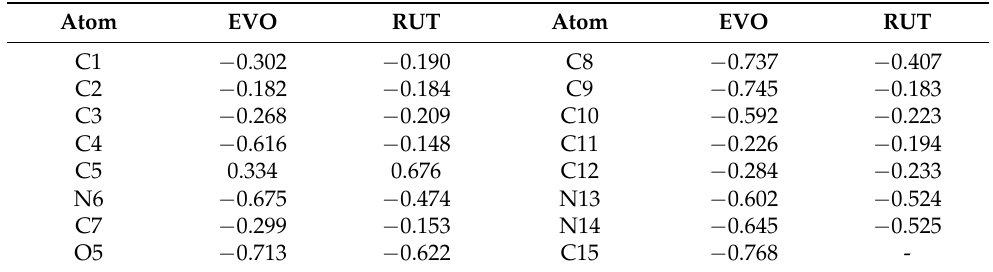
Table 1. Natural population analysis (NPA) charge on the atoms of evodiamine (EVO) and rutae- carpine